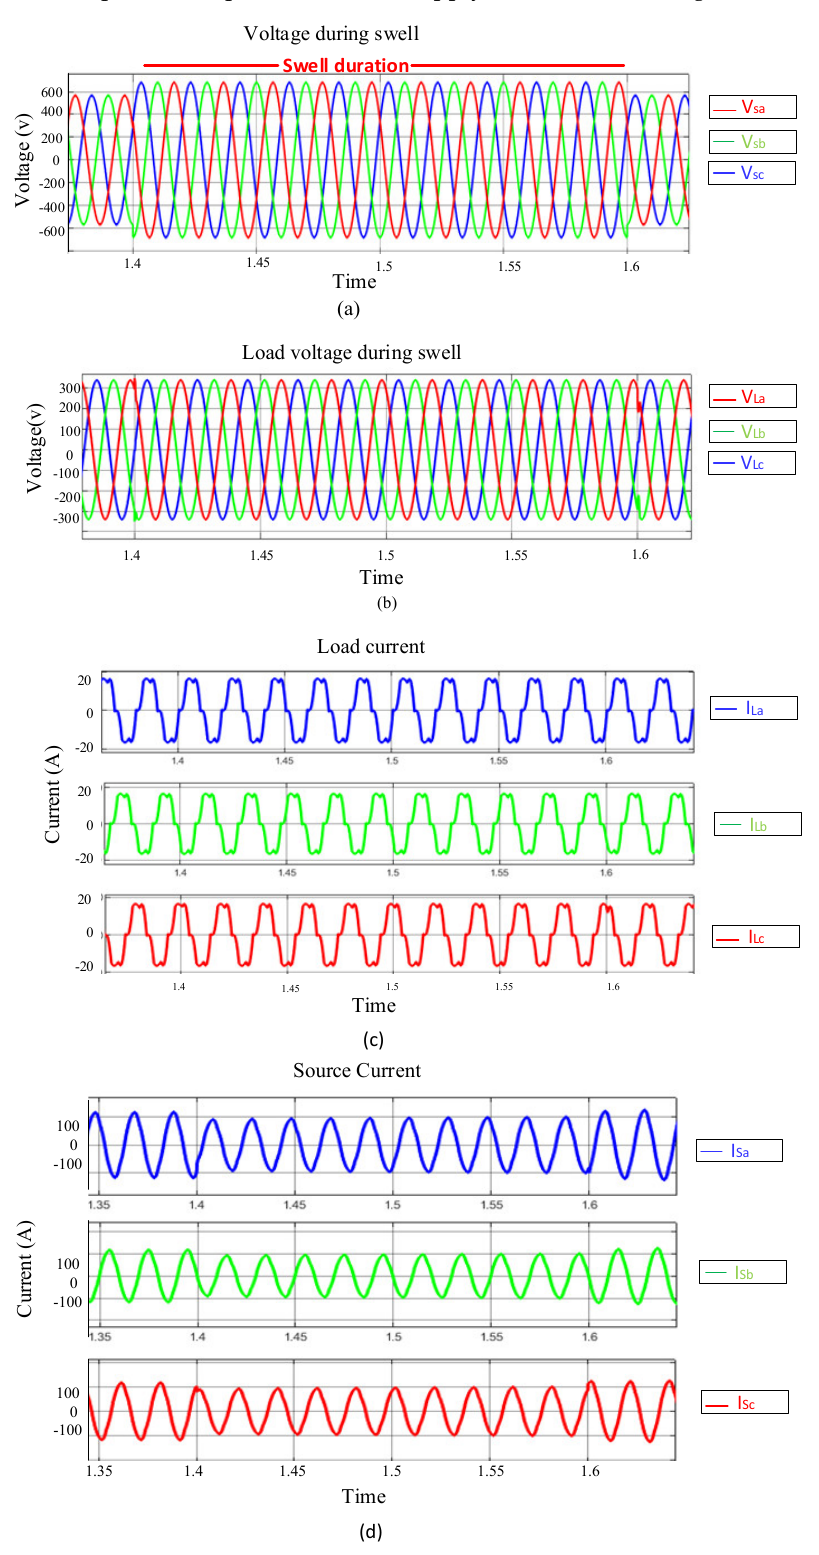
Figure 19. ( a ) Supply voltages ( b ) load voltages ( c ) load currents, before UPQC compensation ( d ) source currents, after UPQC compensation. It is noticed that the ANN based series converter gives or takes the voltage from the line during the sag and swell condition occurred in supply voltage to maintain the load voltage sinusoidal, along with mitigating the harmonics of the load side. It is also noted from Figure 20a that the magnitude feed by the series converter is dependent upon the magnitude of distorted voltage from the component of its fundamental. The voltage in- jected by the series converter during the sag is shown in Figure 20a. 4.6. Injected Current of Shunt Converter The ANN based shunt converter supplies the current in a phase opposite to the har- monics present in load currents produced by unbalanced and non-linear loads; therefore, supply currents must be compensated. It is noted that the magnitude of current fed by the shunt converter is dependent upon the magnitude of distorted current from the compo- nent of its fundamental. The shunt converter fed the reactive currents for supply current compensation, illustrated in Figure 20b.